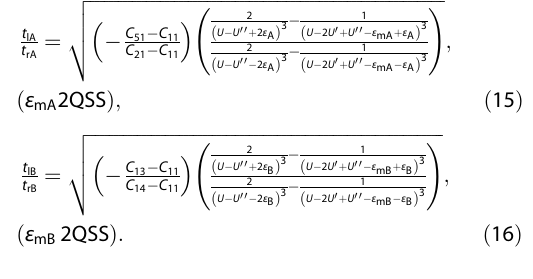
ffiffiffiffiffiffiffiffiffiffiffiffiffiffiffiffiffiffiffi C (cid:2) C 51